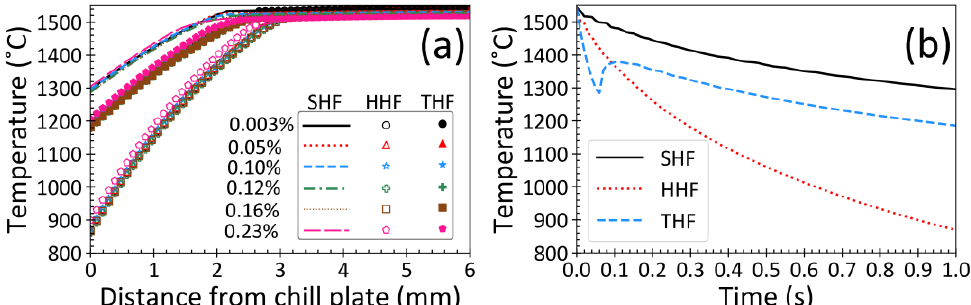
Figure 5. ( a ) Temperature profile through the droplet height calculated at centerline symmetry axis after 1 s of solidification for six steel grades and different heat fluxes, and ( b ) Evolution of bottom surface temperature with time for steel with 0.003%C and different heat fluxes.